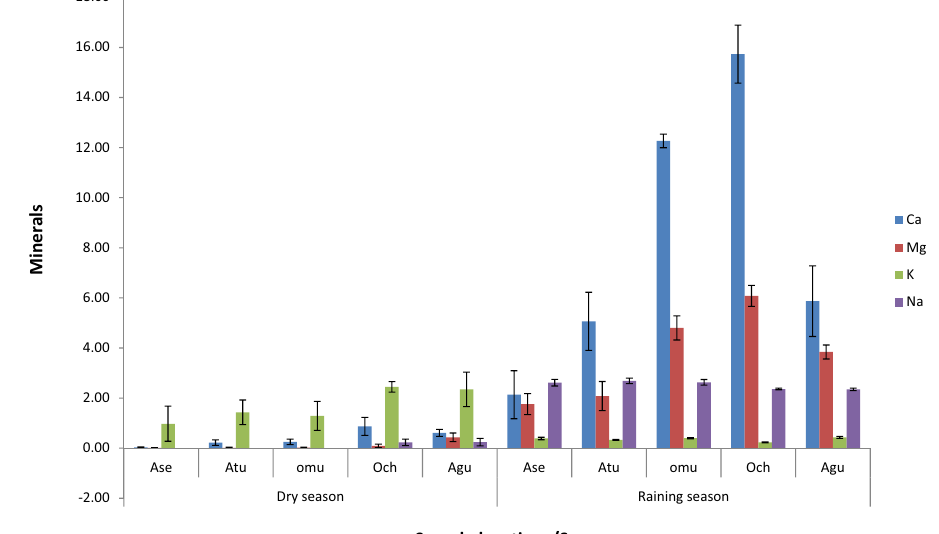
Fig. 2 Seasonal variations of the mineral